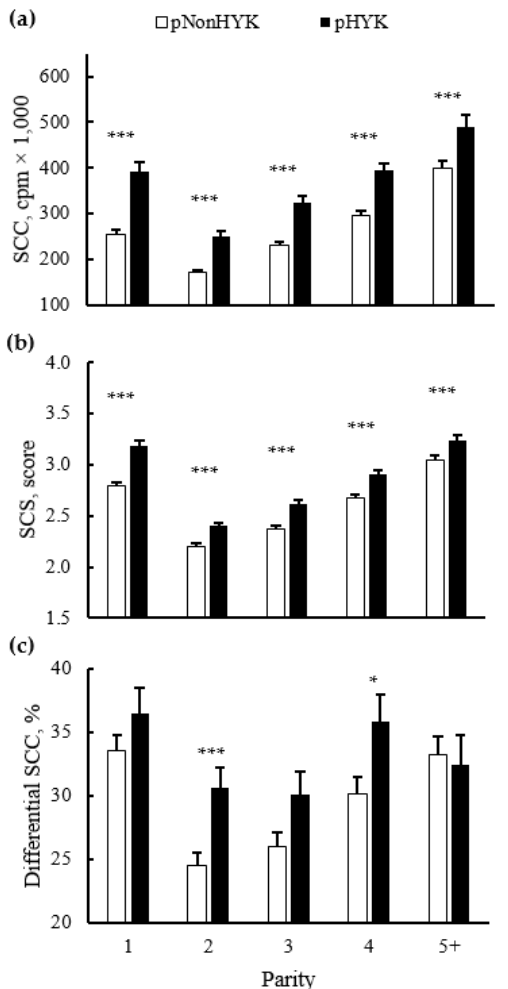
Figure 5. Parity by predicted hyperketonemia (HYK) status interaction on first milk test ( a )